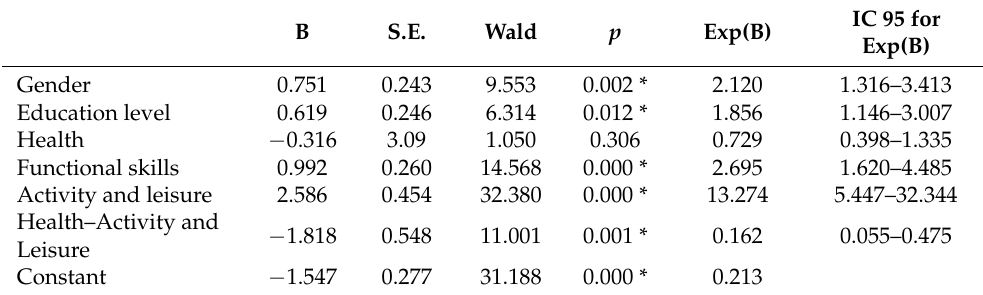
Table 3. Logistic regression model of physical activity